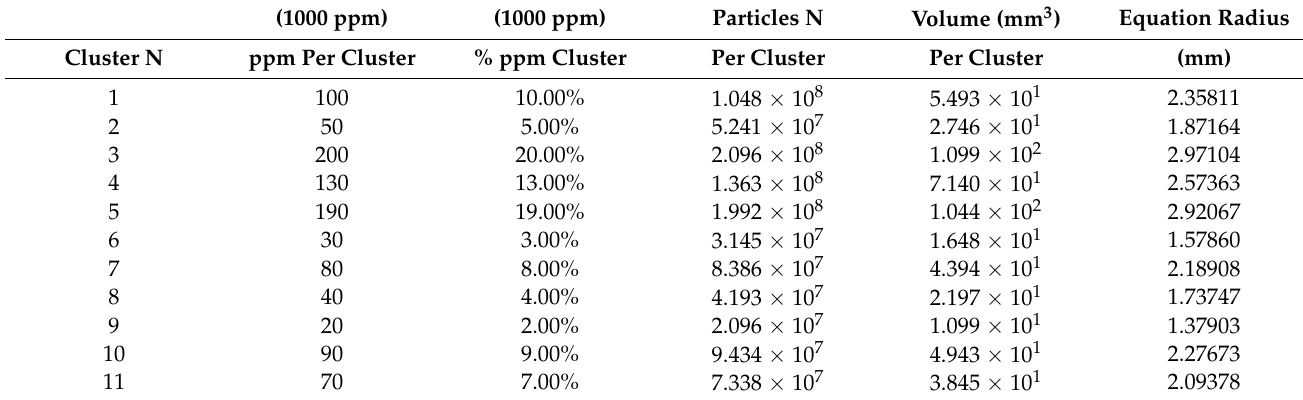
Table 8. Cluster configuration—1000 ppm PO4